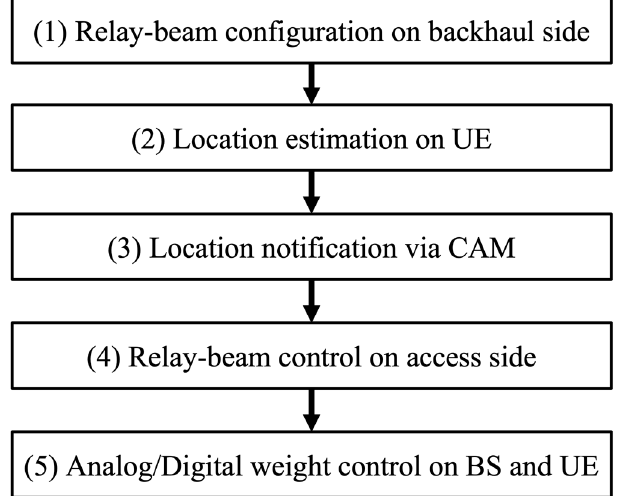
Figure 3. Control flow of the user-driven relay-beam selection.